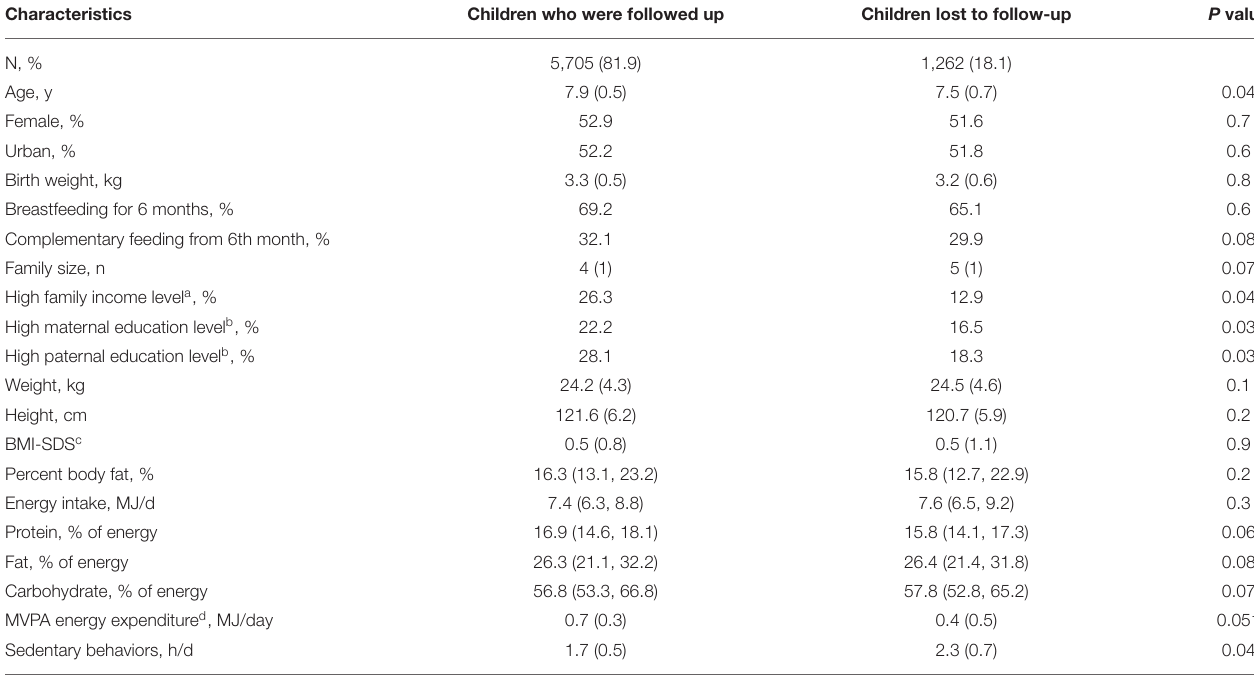
TABLE 3 | Comparison of basic characteristics between children who remained in the cohort for at least once follow-up and those lost to follow-ups. Characteristics Children who were followed